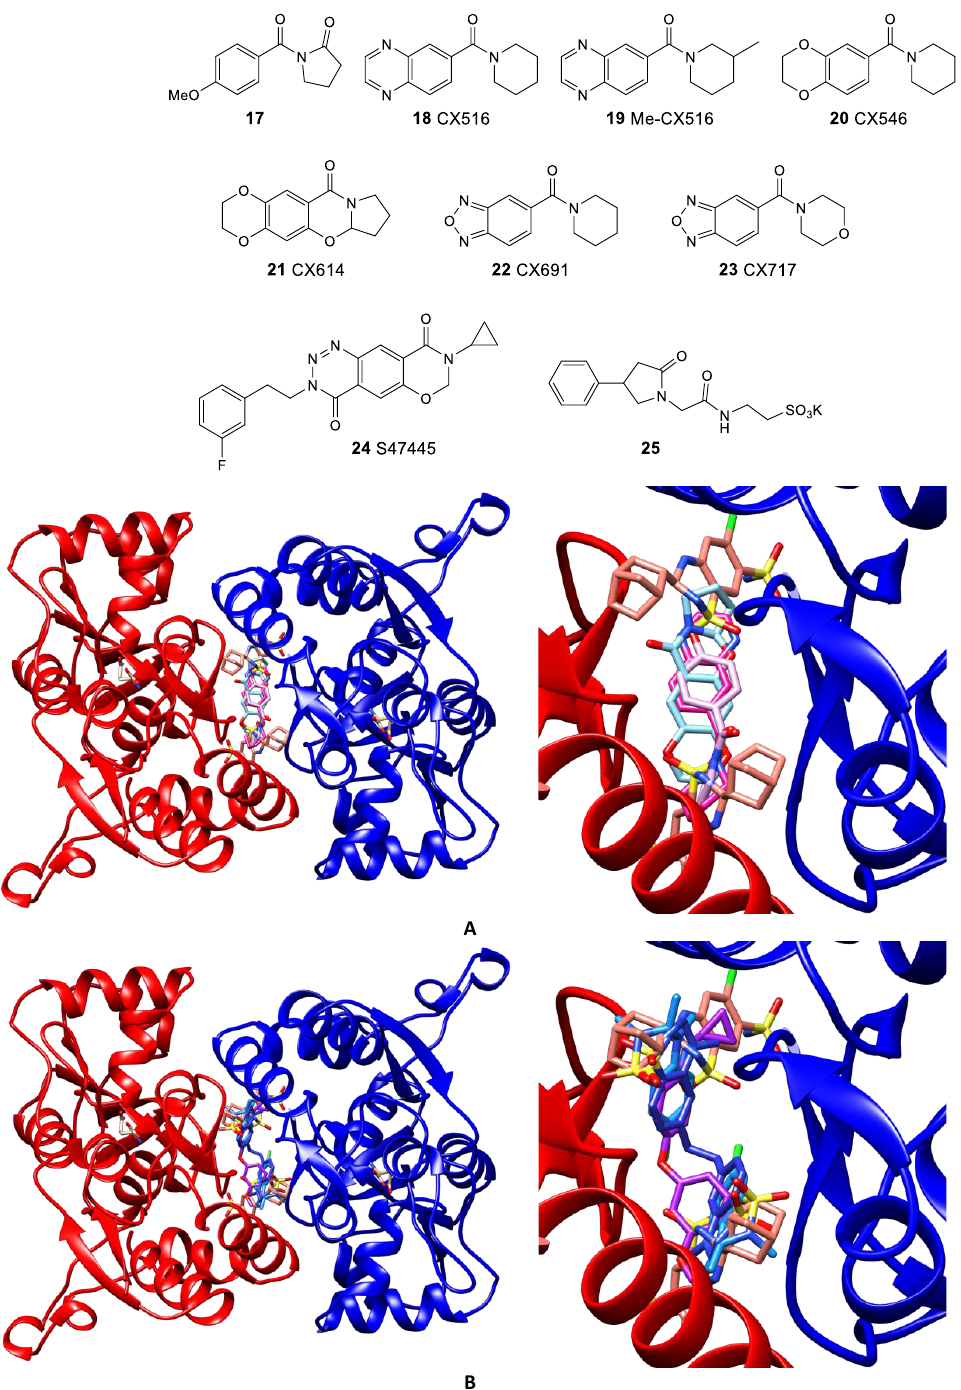
Figure 6. Comparison of the binding modes of AMPA receptor positive allosteric modulators in the dimeric LBD of GluA2 (unless stated otherwise). ( A ) aniracetam ( 17 , pink, GluA3, PDB: 3LSW), CX516 ( 18 , fuchsia, PDB: 4IY5), CX614 ( 21 , cyan, PDB: 2AL4), and cyclothiazide ( 26 , salmon, PDB: 3TKD). ( B ) cyclothiazide ( 26 , salmon, PDB: 3TKD), BPAM-321 ( 27 , dodger blue, PDB: 5BUU), BPAM- 538 ( 29 , purple, PDB: 5OEW), and TDPAM01 ( 30a , cobalt blue, PDB: 6FAZ). Left—general view, right—detailed binding mode. For clarity, only one symmetrically equivalent orientation is shown for each ligand. The aligned receptor subunits are shown in blue and red, and the agonist (glutamate) molecules bound in the orthosteric binding sites are shown in